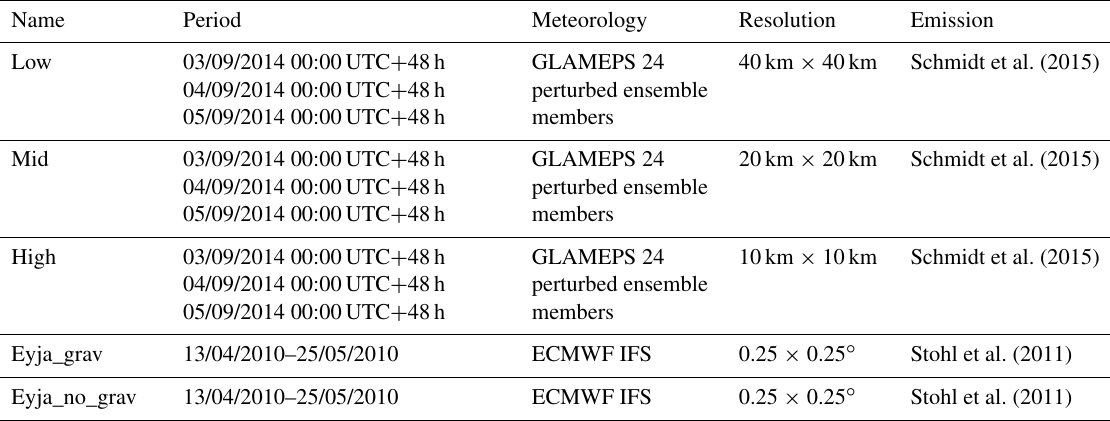
Table 1. List and names of model simulations used in this paper. Name Period